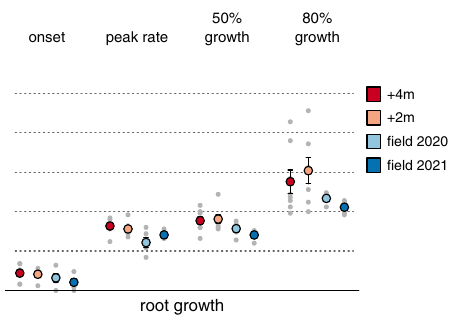
rate, 50% and 80% seasonalgrowth forroots. GSLamounted to 238d (+4m),174 d (+2m), 109 d ( fi eld 2020) and 103 d ( fi eld 2021). Grey points show data for each monolithand fi eldplot(8monolithsfor+4mand+2mand fi ve fi eldplots),colored points refer to mean±SE (SE smaller than points are not